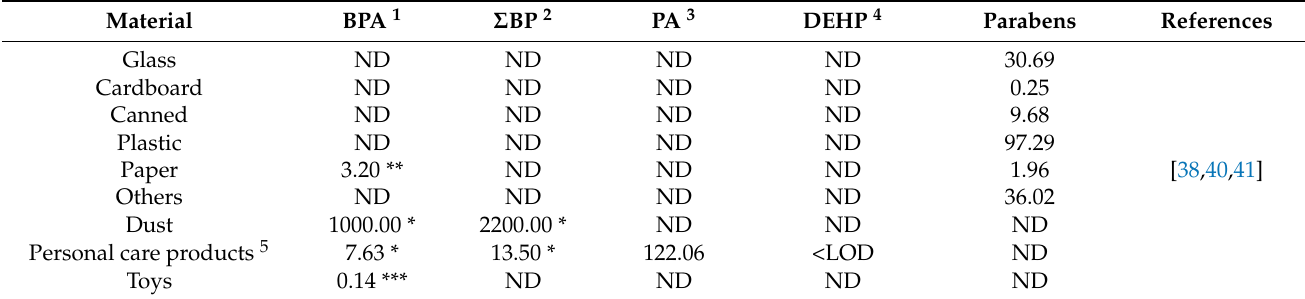
Table 3. Levels of selected EDCs in different packaging materials ( µ g × g − 1